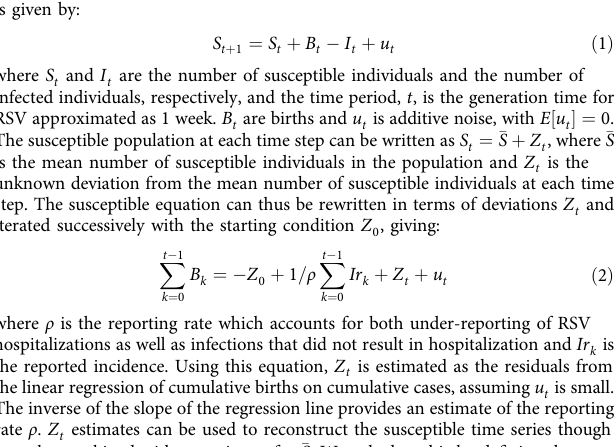
Fig. 3a, as well as the ratio of biennial to annual Fourier amplitudes in Supple- mentary Fig. 3b 27 ). When running simulations for Fig. 3, we de fi ne chaotic regions as locations where the Lyapunov constant is positive. To calculate mean onset week we fi rst calculate mean incidence per week (i.e., each week averaged over all years for a given locations), and then normalize these values between 0 and 1. We de fi ne the start of the epidemic period as the 26th week of the year, approximately the fi rst week of July. This period is chosen as it spans all epidemics within our data (Supplementary Fig. 6). We de fi ne onset as when normalized incidence exceeds 0.2, assuming this value is low enough to constitute onset but high enough to exceed random fl uctuations in the data. Using normalized incidence, as opposed to incidence/population thresholds, allows to create a uniform measure across both US and Mexican datasets in spite of sampling differences between the two locations.